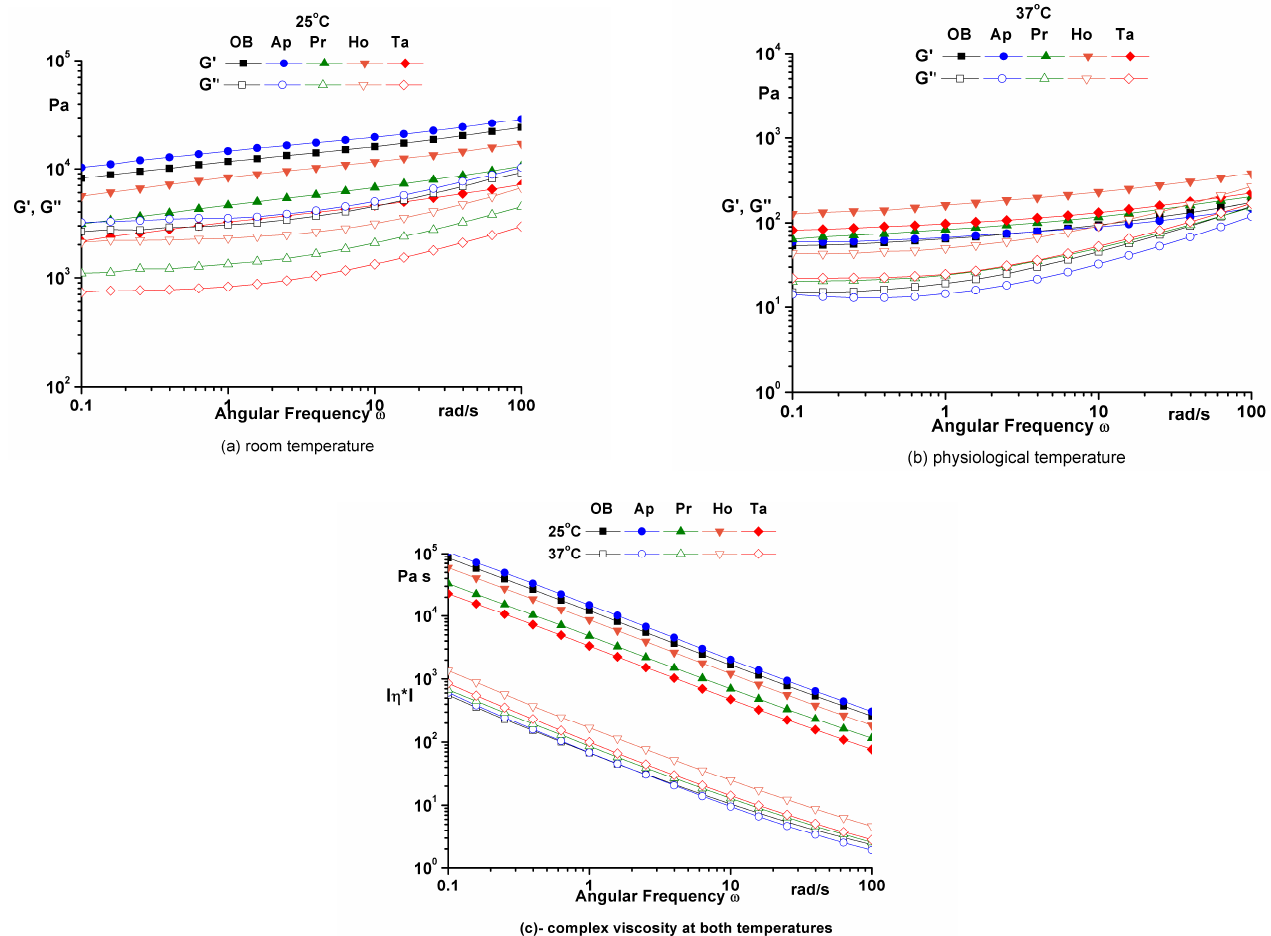
Figure 3. Frequency sweep for analyzed ointments. OB—ointment base, Ap—ointment base + apilarnil, Pr—ointment base + propolis, Ho—ointment base + honey, Ta—ointment base + mixture of bee products.